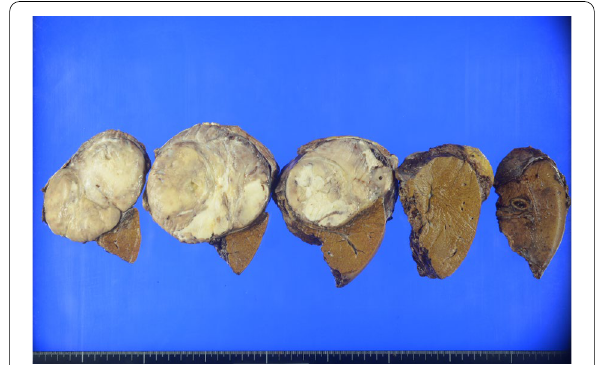
Fig.3 Macroscopic of the resected specimen. A well‑circumscribed nodular tumor of 11 10 8.5 cm in size was located just below the × × hepatic capsule/intraparenchymal space and was adherent to the diaphragm, but there was no continuity with the diaphragm